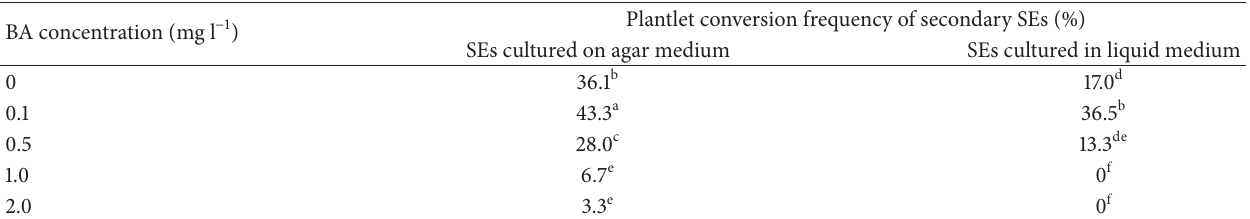
Figure1:CyclicsomaticembryogenesisfromgerminatedSEsonagarmedium.(a)EmbryogeniccalliformeddirectlyfromgerminatedSEson medium without plant growth regulators. (b) Close view of embryogenic calli formed from the primary SEs. (c) Embryogenic calli developed into cotyledonary SEs. (d) Plantlets from germinated SEs. Bars = 15mm (a), 2 mm (b), 2mm (c), and 15mm (d). Table 4: Effects of BA supplementation on plantlet conversion of H. dulcis secondary SEs after 2 month-culture on 1/3-strength MS agar medium at 20 ∘ C X